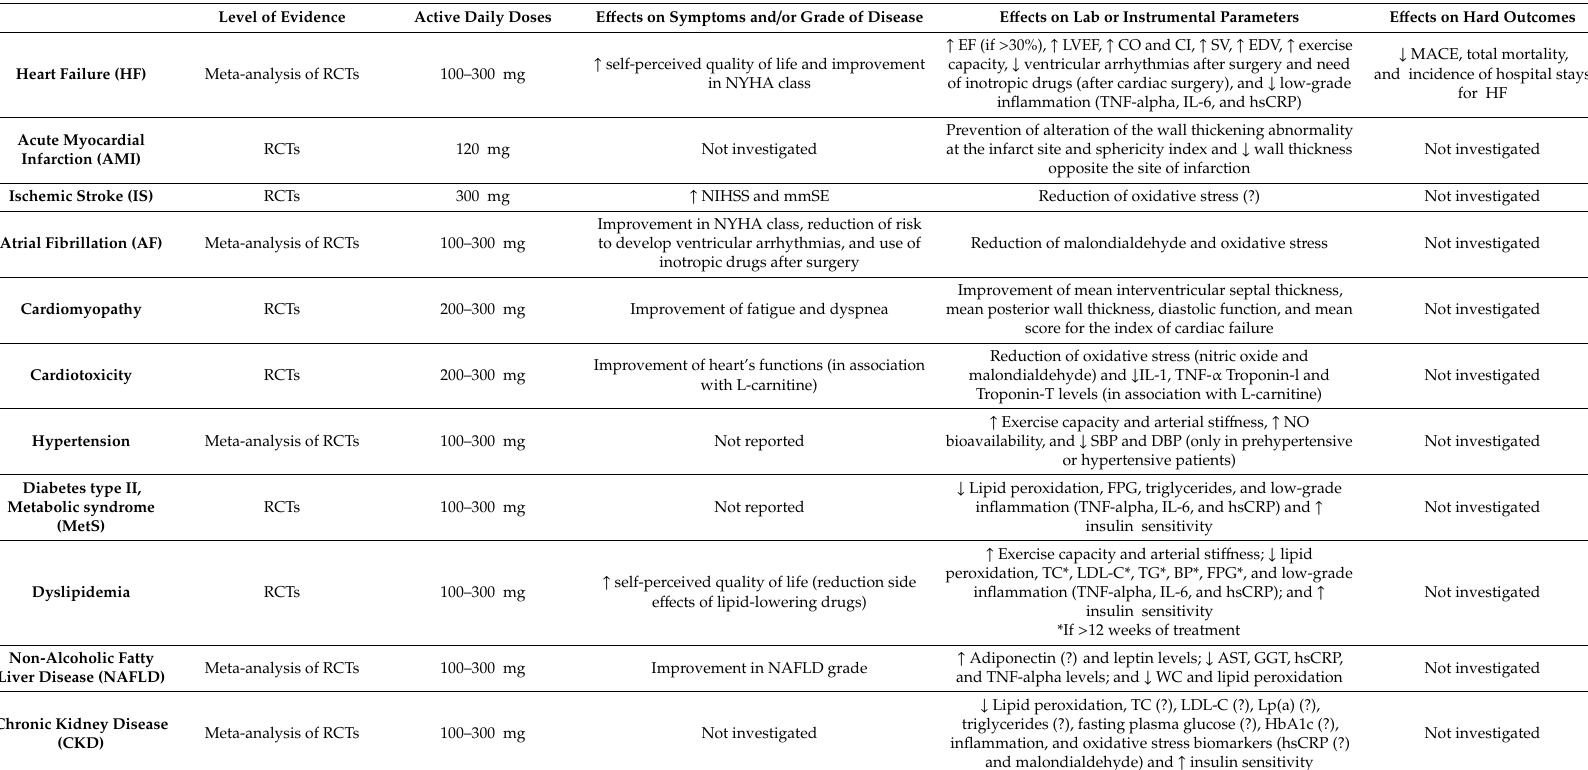
Table 2. Coenzyme Q 10 : clinical applications in cardiovascular